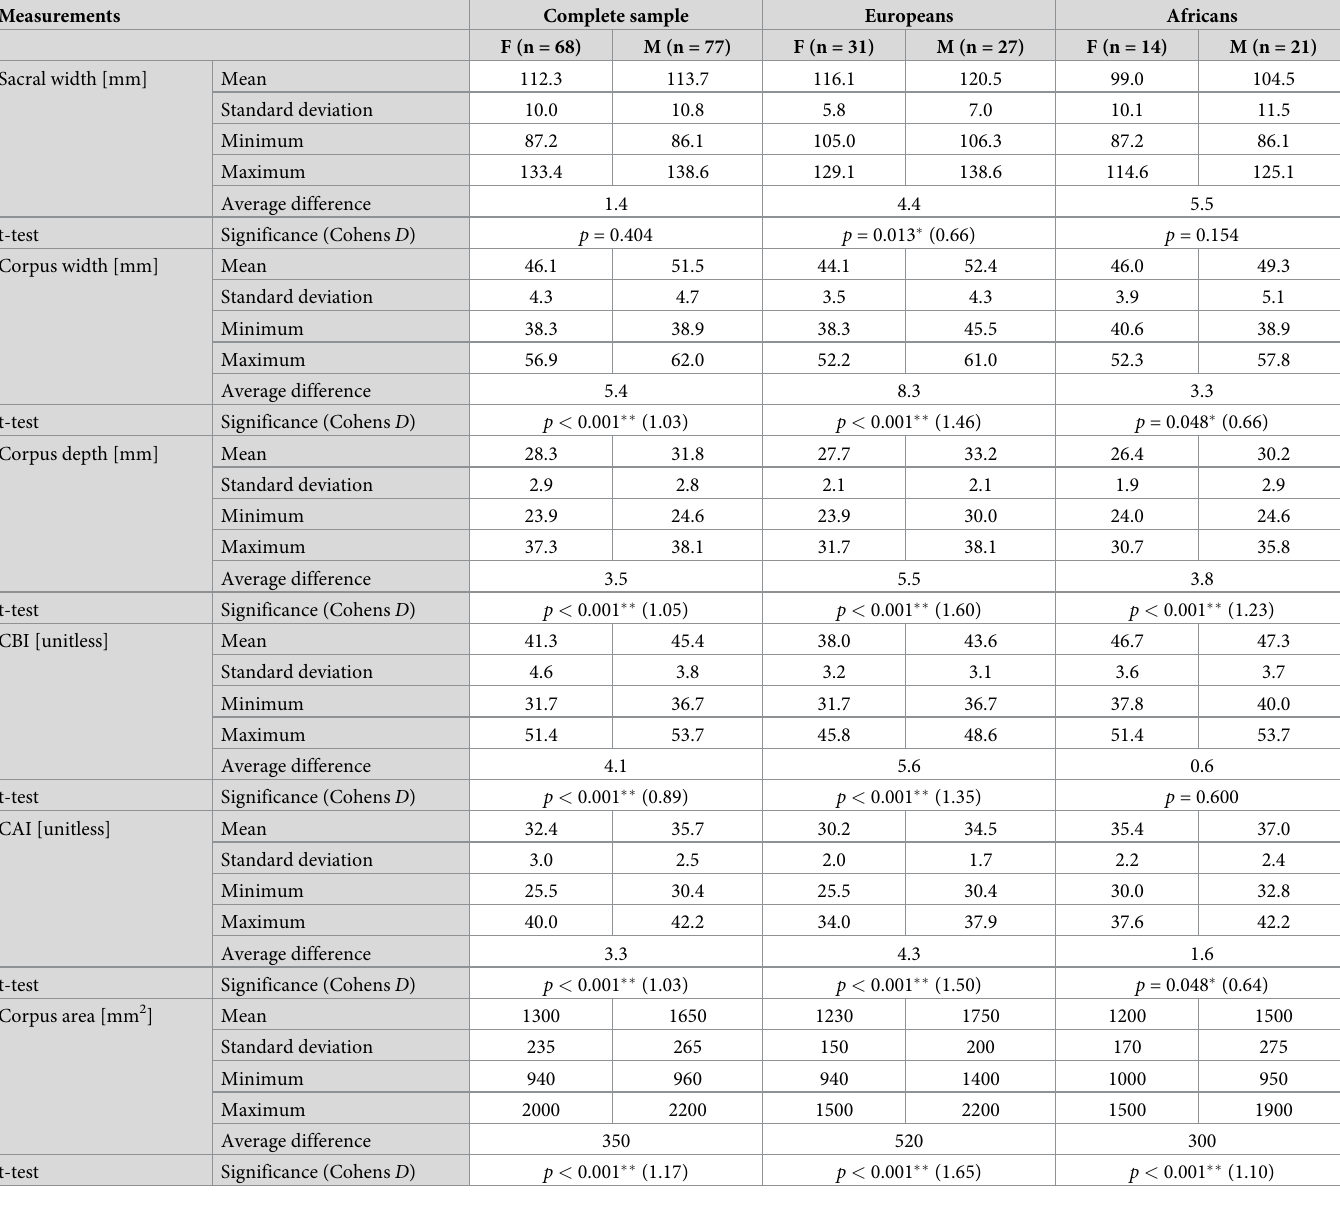
Table 4. Univariate statistics of the linear measurements.